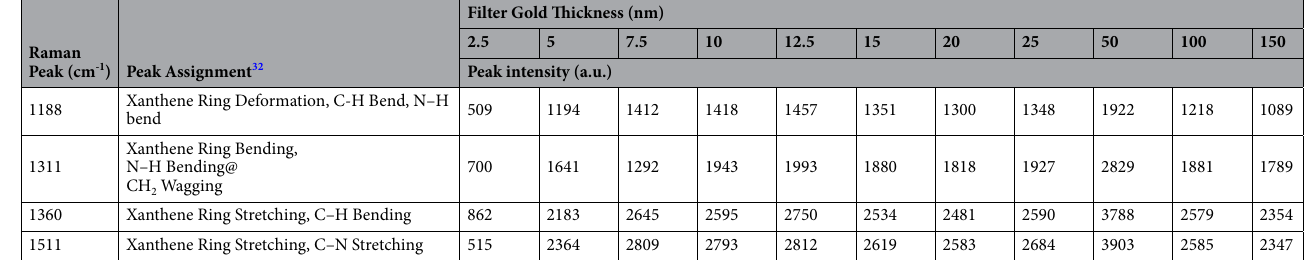
Table 1. Rhodamine 6G peak intensities observed with different gold coating thicknesses for the four most prominent spectral peaks.